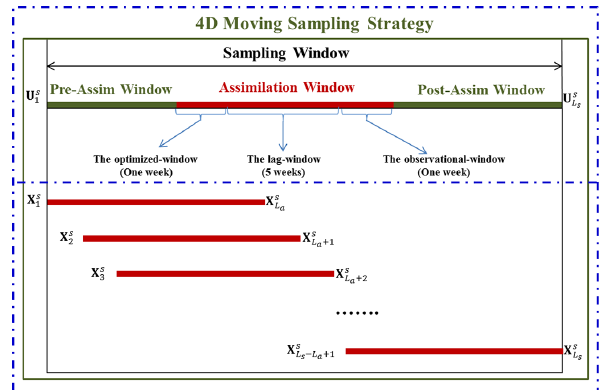
Figure 2. The 4-D moving sampling